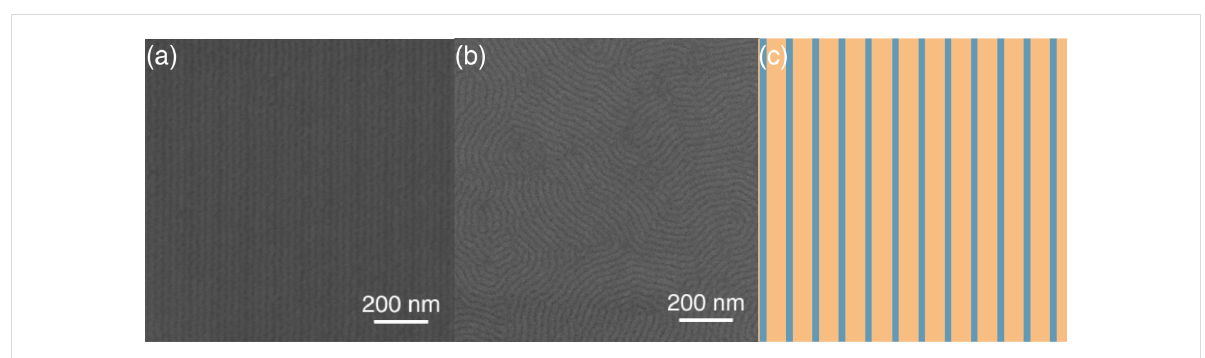
Figure 2: SEM images of PS- b -PMMA BCP after removal of the PMMA blocks prepared after EBL and oxygen plasma functionalization of grafted PS–OH layers deposited on silicon wafers (see Figure 1) after (a) annealing at 230 °C and cooling in nitrogen and (b) annealing at 260 °C and cool- ing in air. (c) Scheme of the induced patterns (same scale as in (a) and (b)).